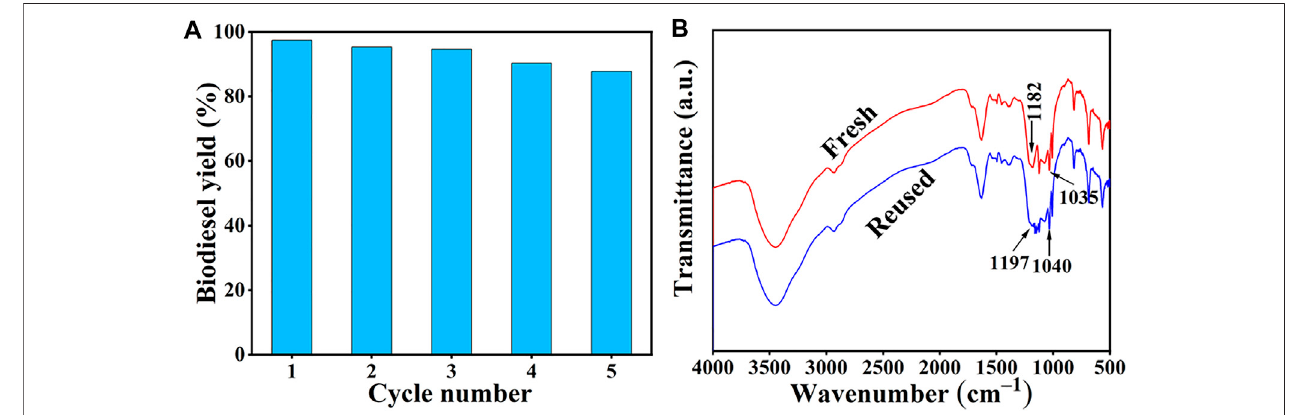
Frontiers in Chemistry |